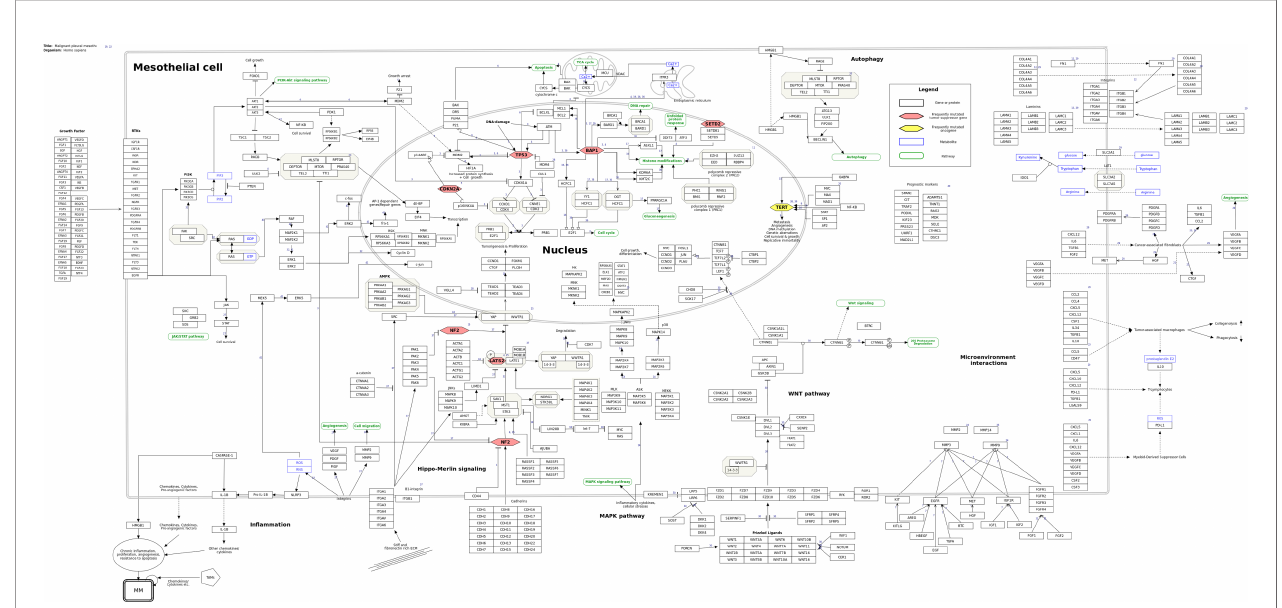
FIGURE 1 | Molecular pathway of Malignant Pleural Mesothelioma from WikiPathways (wikipathways.org/instance/WP5087). Genes and proteins are visualized as black rectangles, and frequently mutated tumor-suppressor genes and oncogenes are indicated as red and yellow diamonds, respectively. Blue rectangles indicate metabolites and green rounded rectangles are links to other pathway entries in the WikiPathways